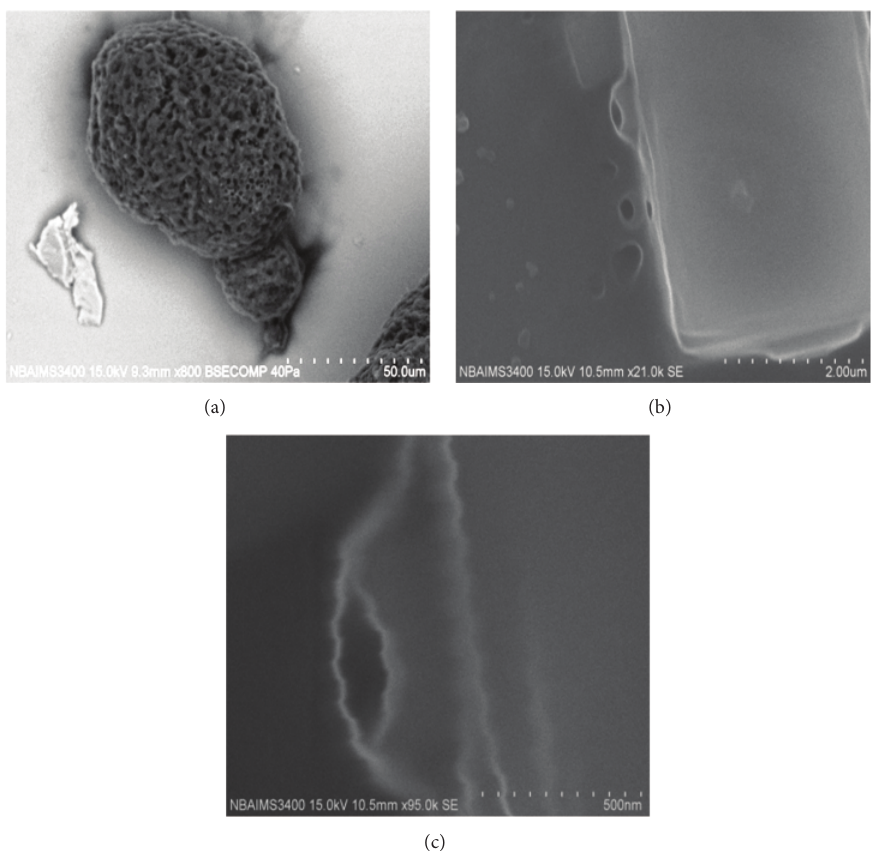
Figure 2: Scanning electron microscopy (SEM) of Streptomyces cellular isolate isolated from Sambhar salt lake, India, (a) showing globular sporangiophore, (b) sporangial pore, and (c) enlargement showing wavy sporangial pore